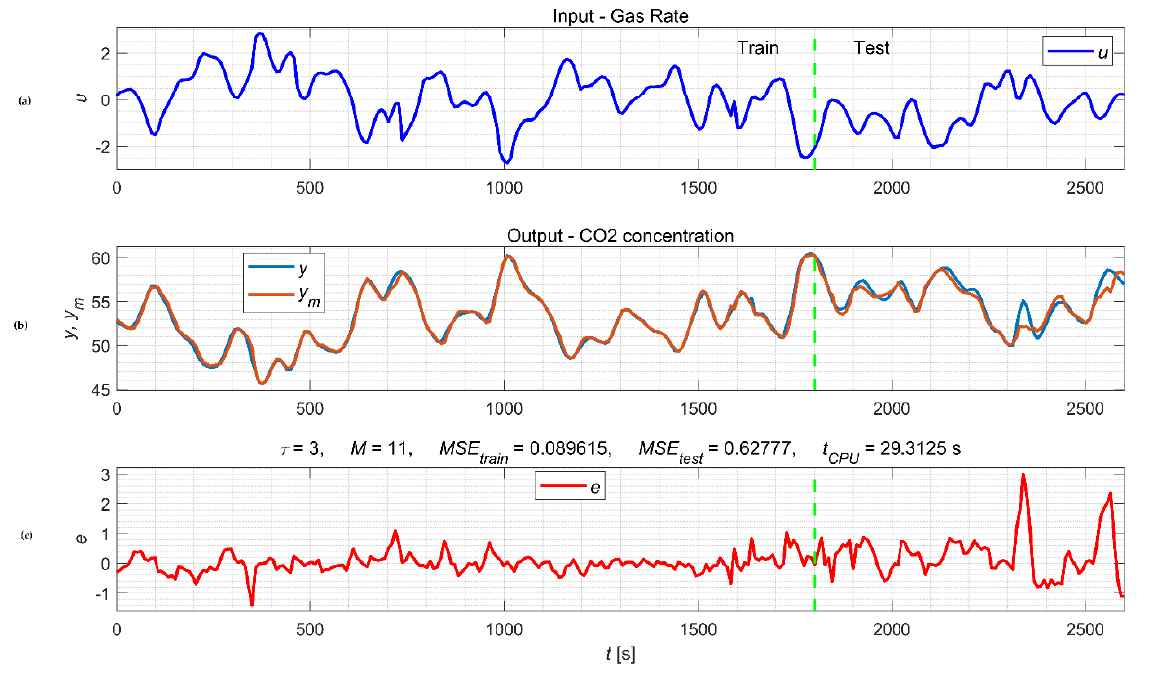
Figure 5. Comparison of WM FS model output and original system output for Box and Jenkin’s gas furnace data set: ( a ) input signal—gas rate, ( b ) outputs comparison, and ( c ) respective error. The green line divides the training data from the test data.